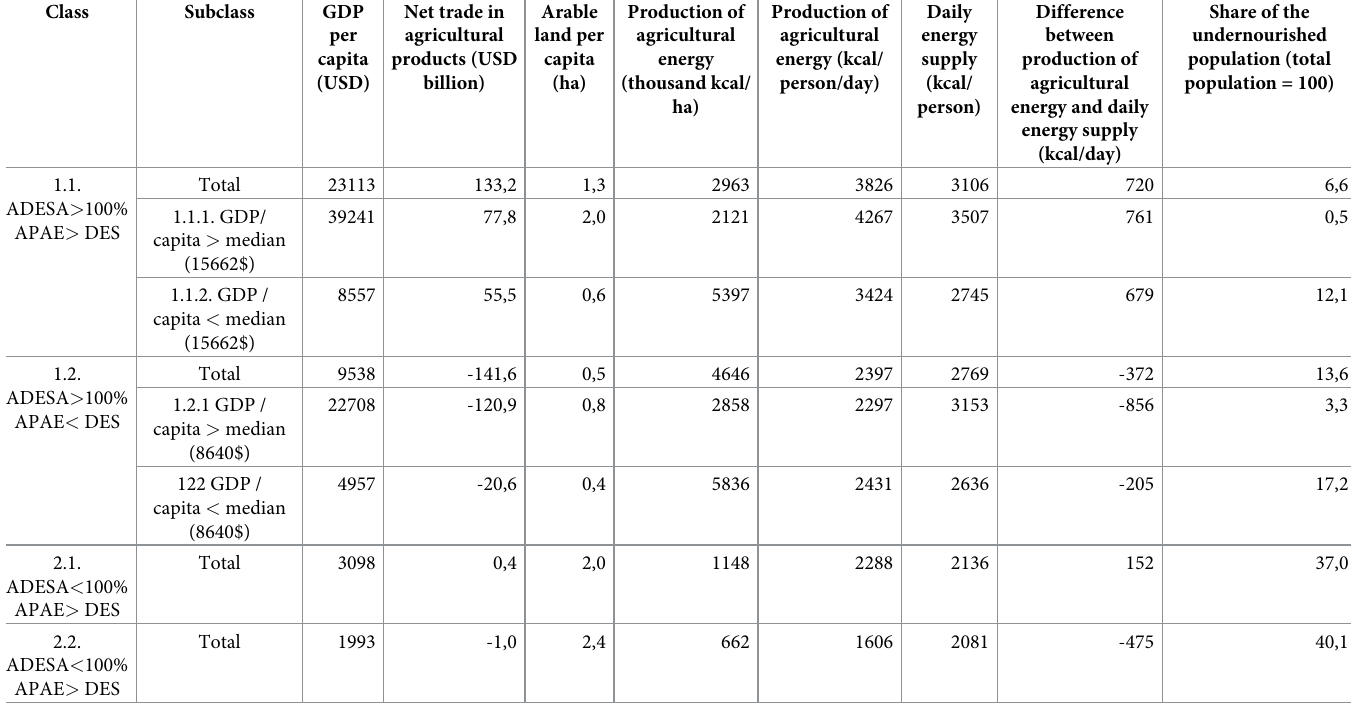
Table 2. Production, economic and natural aspects of food security in classes and subclasses identified (2000–2013 average